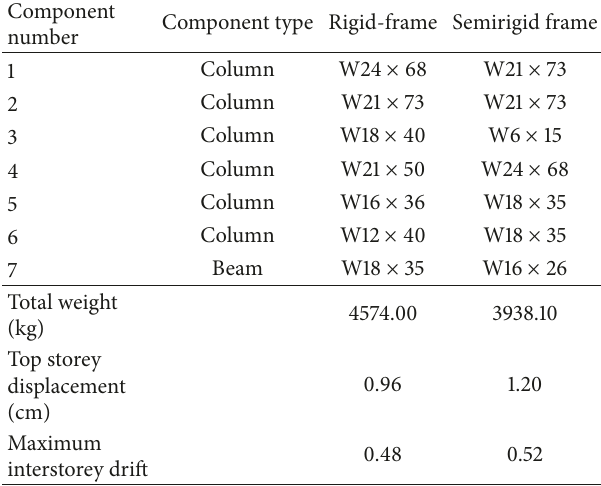
Table 1: Structural performance of frame with semirigid and rigid connections [21].